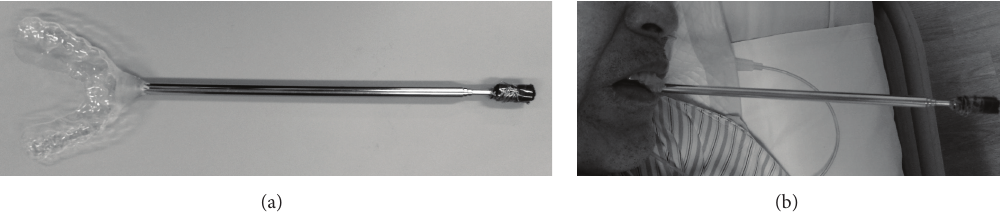
Figure 2: Modified mouthstick stylus. (a) shows an overview of the modified mouthstick stylus. (b) shows the mouthstick stylus fixed on the maxillary teeth. The patient can use this stylus without